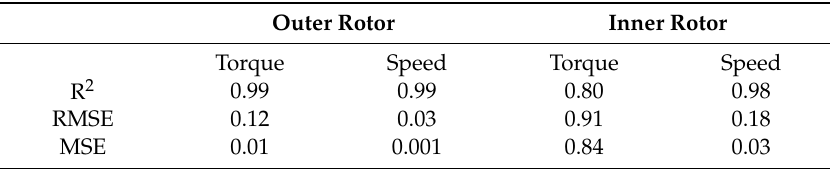
Table 6. Statistical performance analysis results, ECMS-based case